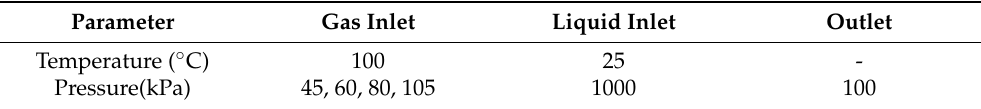
Table 23. Assumed boundary conditions from Koirala et al.